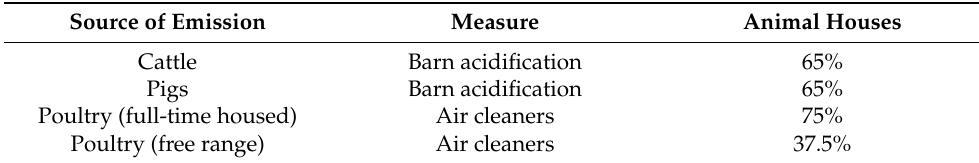
Table 1. Relative reduction factors in NH 3 emission that are due to barn acidification and air cleaners compared to untreated barns in the baseline scenario. Source: [8,41].